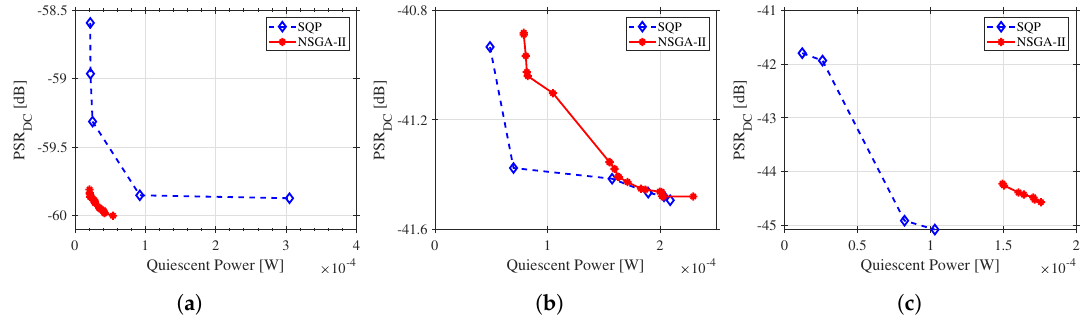
Figure 11. Pareto front of the optimization of the LDO circuit using SQP and NSGA-II